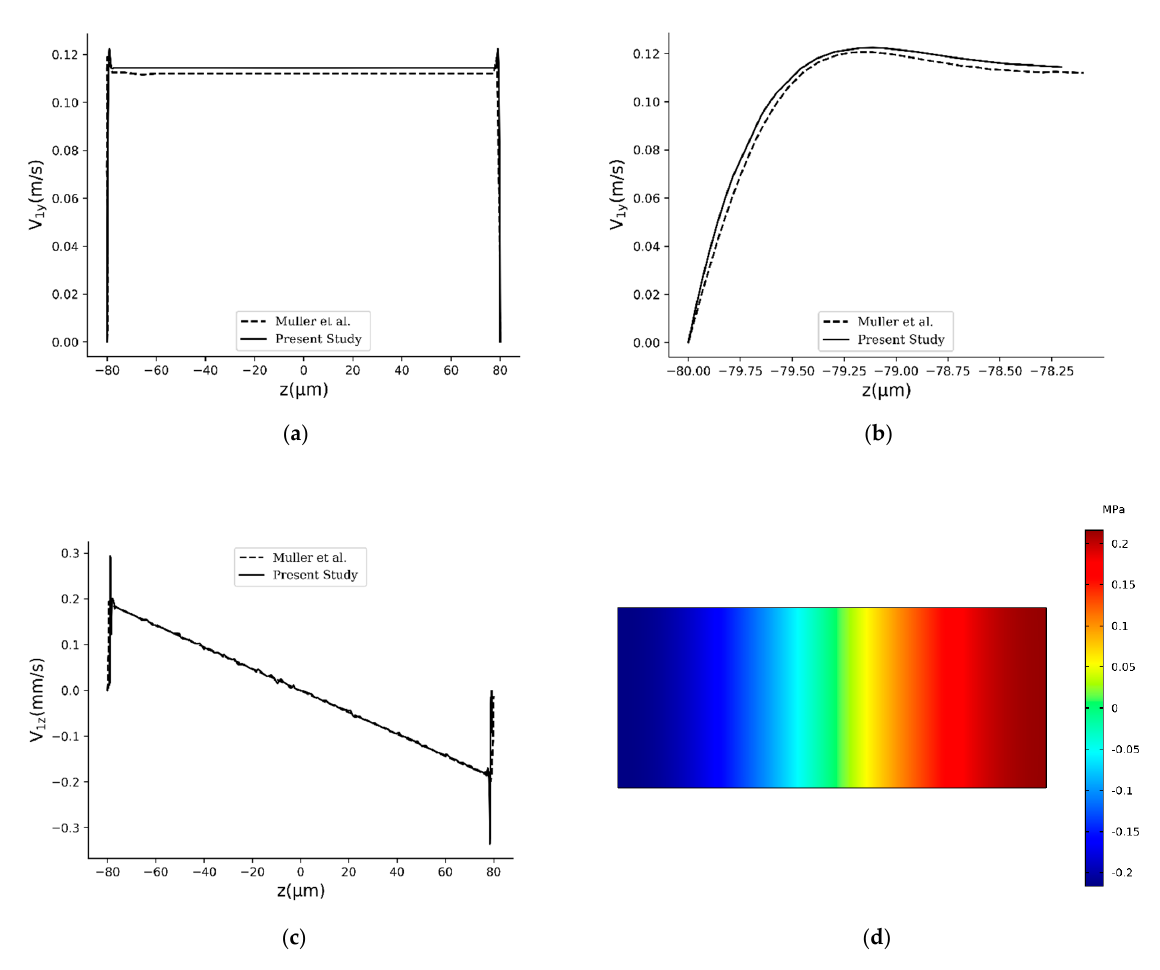
Figure 4. Comparison between the results obtained in this study for the geometry and boundary conditions of the problem in [43] and present results. ( a ) Comparison between the vertical velocities, ( b ) comparison between the vertical velocities in the near-wall region, and ( c ) comparison between the horizontal velocities. All the sub-figures ( a – c ) are plotted on the white dashed line shown in Figure 3. Sub-figure ( d ) depicts the pressure contour for the problem, which is identical to its counterpart in [43] (Figure 4a in that study).